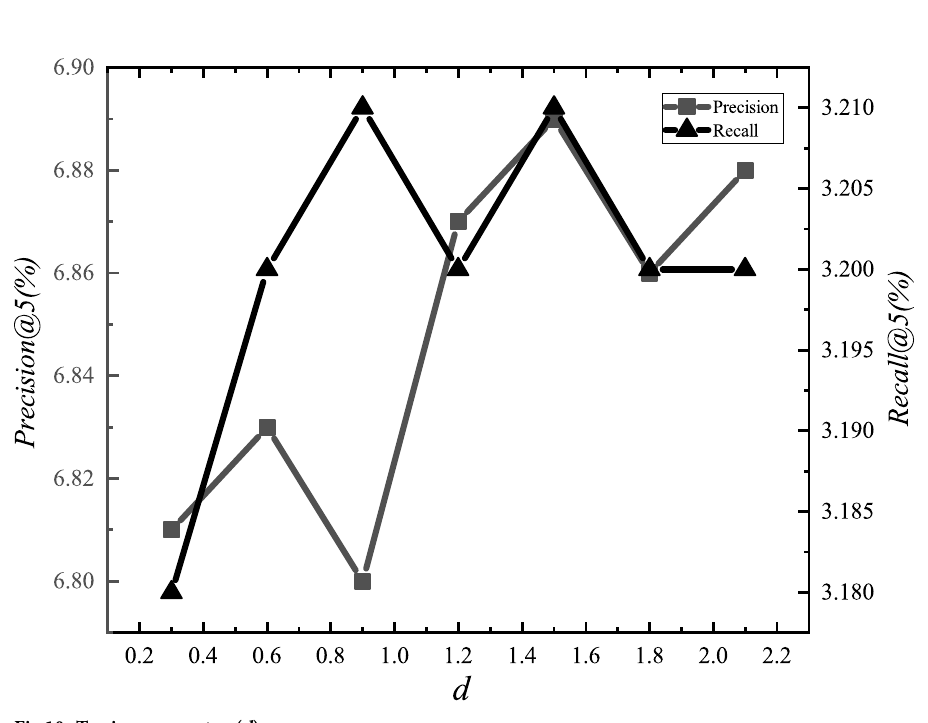
Fig 10. Tuning parameters( d